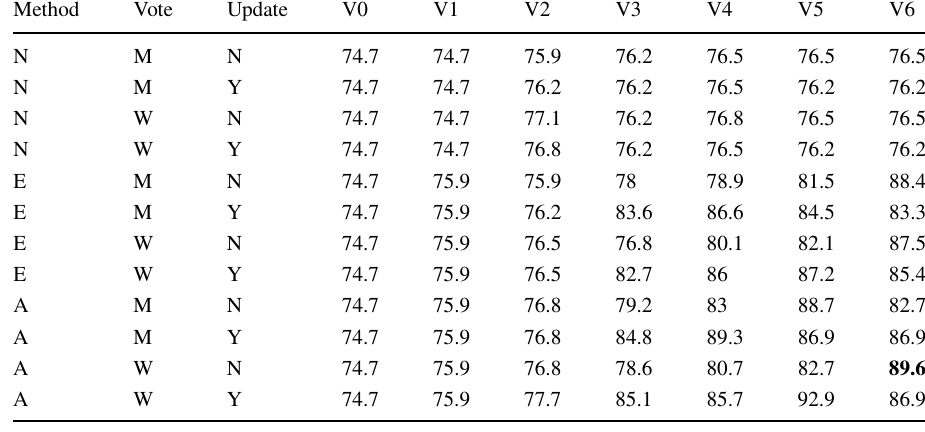
Table 5 Occupancy sensitivity